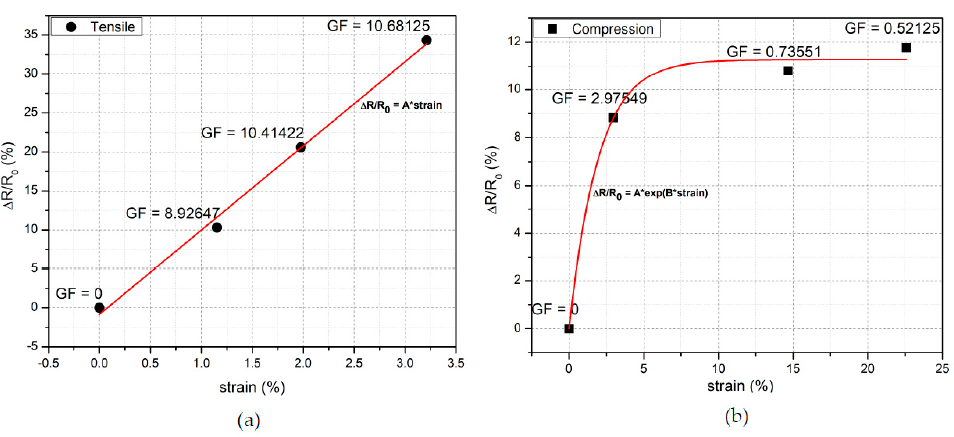
Figure 5. The relative change of the resistance versus ( a ) tensile strain and ( b ) compressive